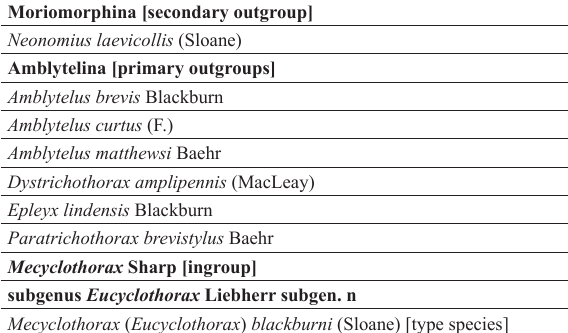
Table 1. Species-level taxa included in cladistic analysis. Me- cyclothorax subgeneric classification based upon results of cladistic analysis. Type species indicated for Mecyclothorax generic-level taxa. Mecyclothorax andersoni represented by infraspecific aedeagal forms with either a short or long median lobe apex (Liebherr 2017b). Mecyclothorax sp. n. D treated as non-valid terminal; species to be described